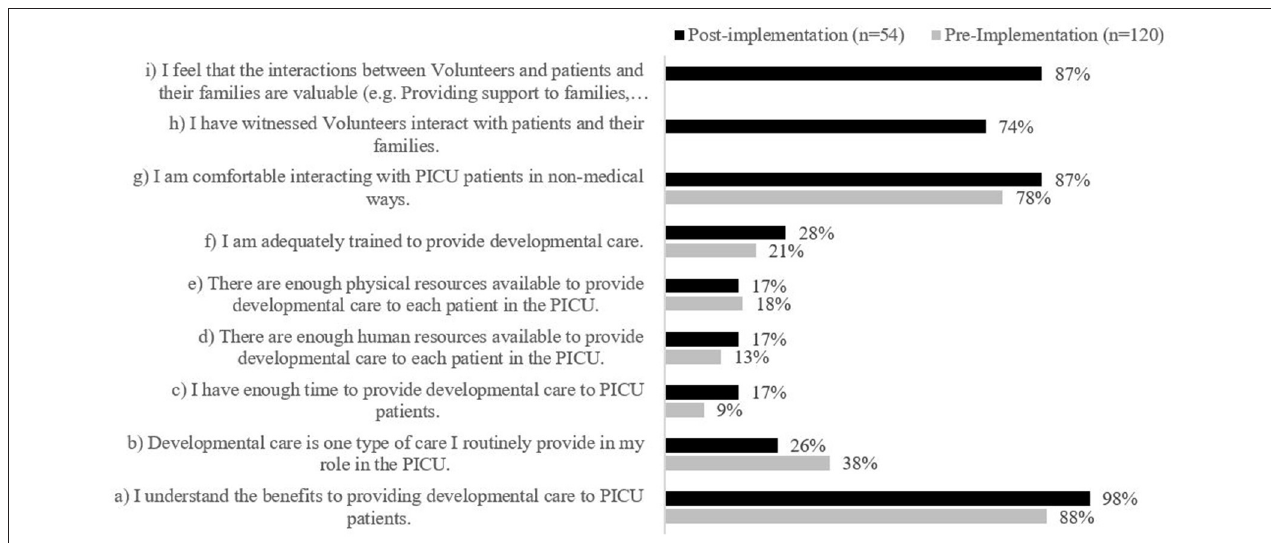
FIGURE 3 | Staff level of agreement regarding statements on developmental care and the volunteer program pre- and post-implementation. Statements (h) and (i) were not included as survey items in the staff pre-implementation survey; therefore, no data is displayed.